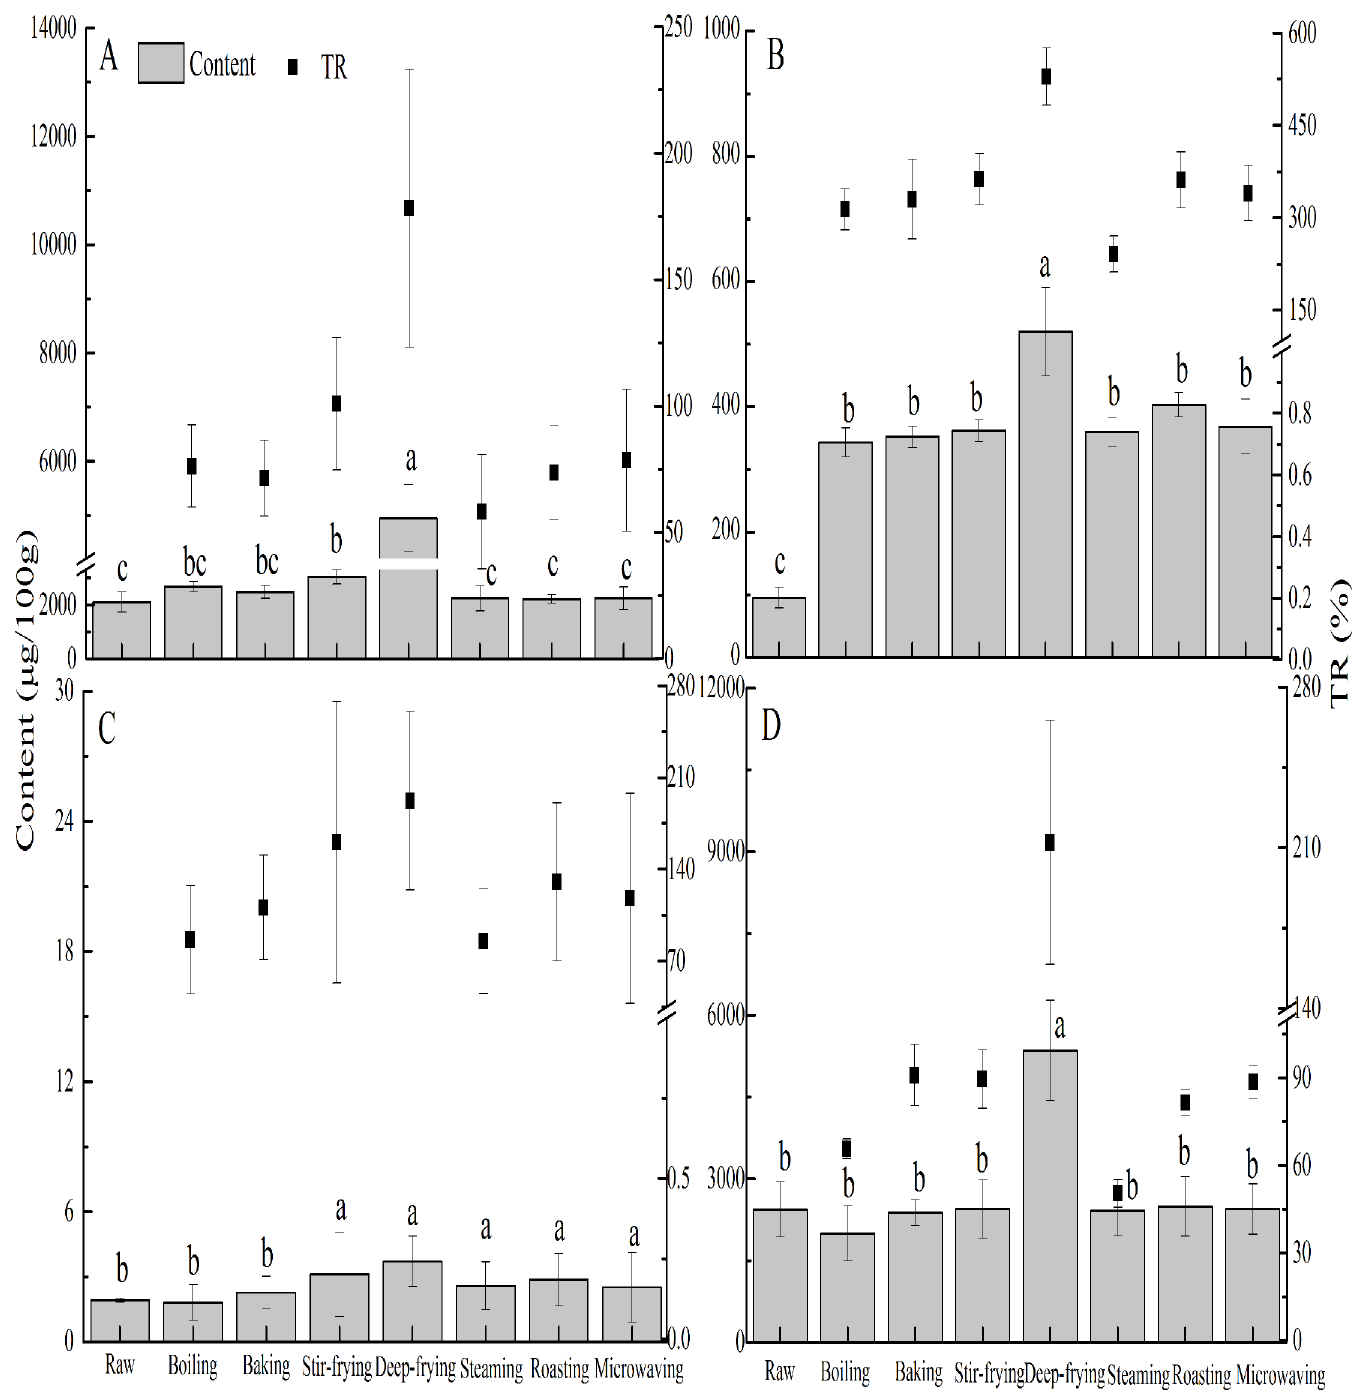
Fig 5. The content of β -carotene(histogram) and related true retention (TR) ( ■ ) of crown daisy (A), unripehot pepper(B), garlic (C) and red pepper(D). Values are presented as mean ± SD of three measurements. Bars of histograms ( β -carotene content) with same letters are not significantly different (p >